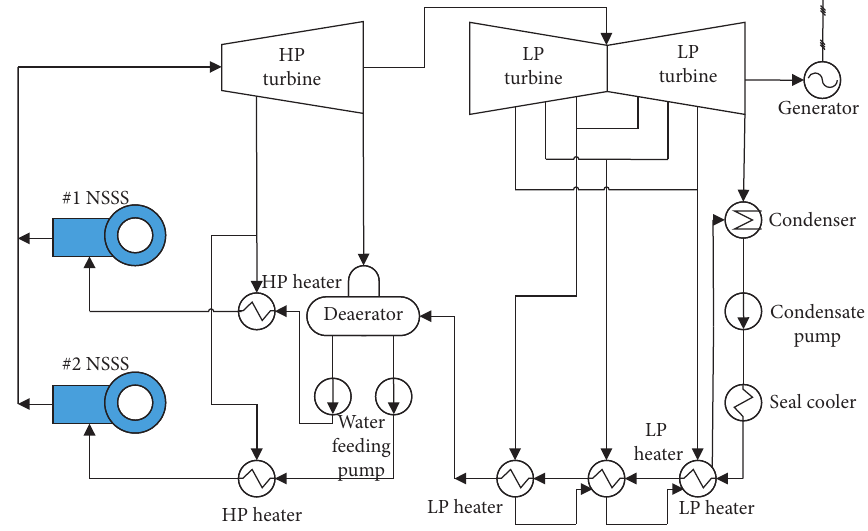
Figure 1: Flow diagram of power conversion [3]. Table 1: Main design parameters of the HTR-PM